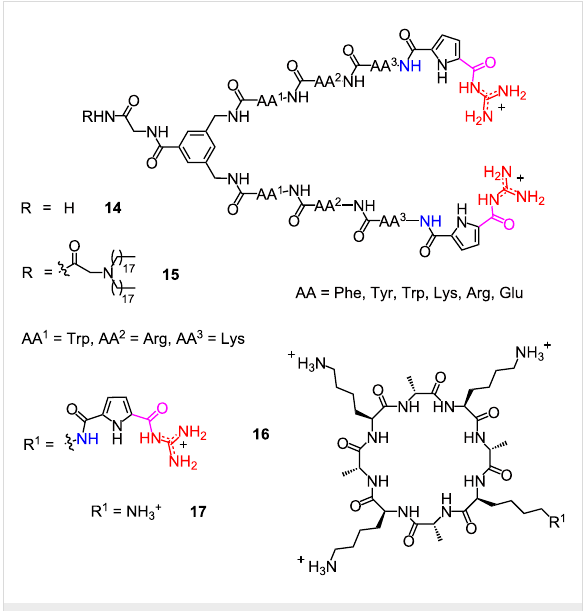
Figure 3: Peptide tweezers and cyclic peptides with Schmuck cations for gene transfection.